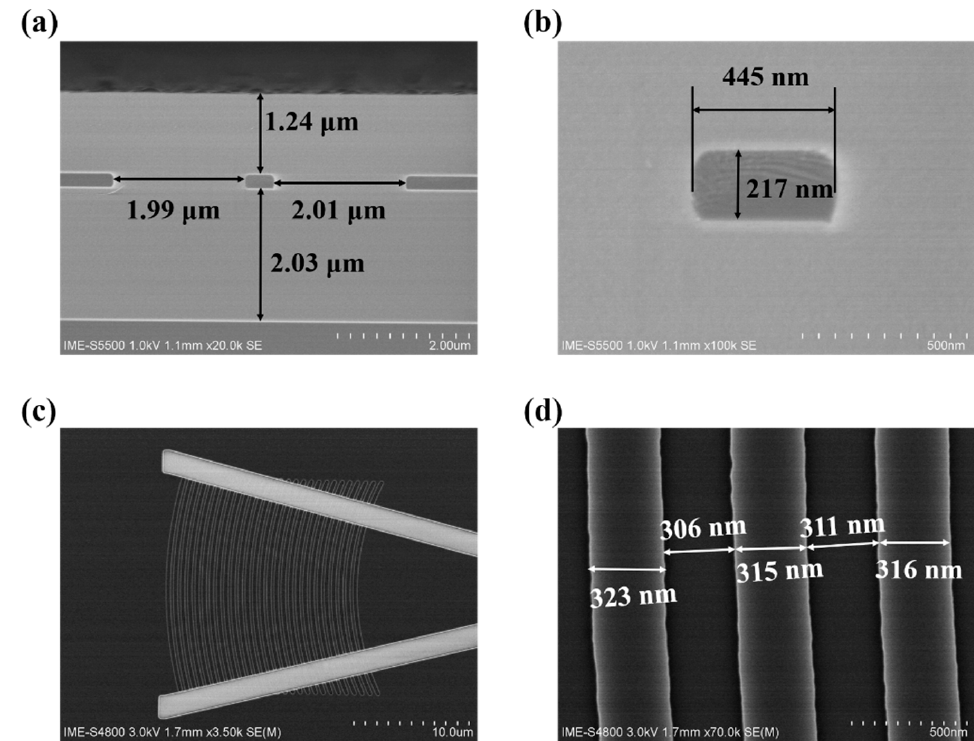
Figure 3. SEM image of waveguide and gratings. ( a ) Cross-section SEM image of the optical waveguide; ( b ) Cross-section SEM image of the core of the waveguide; ( c ) Topography SEM image of the grating (overview); ( d ) Topography SEM image of the grating (Zoom-in view).